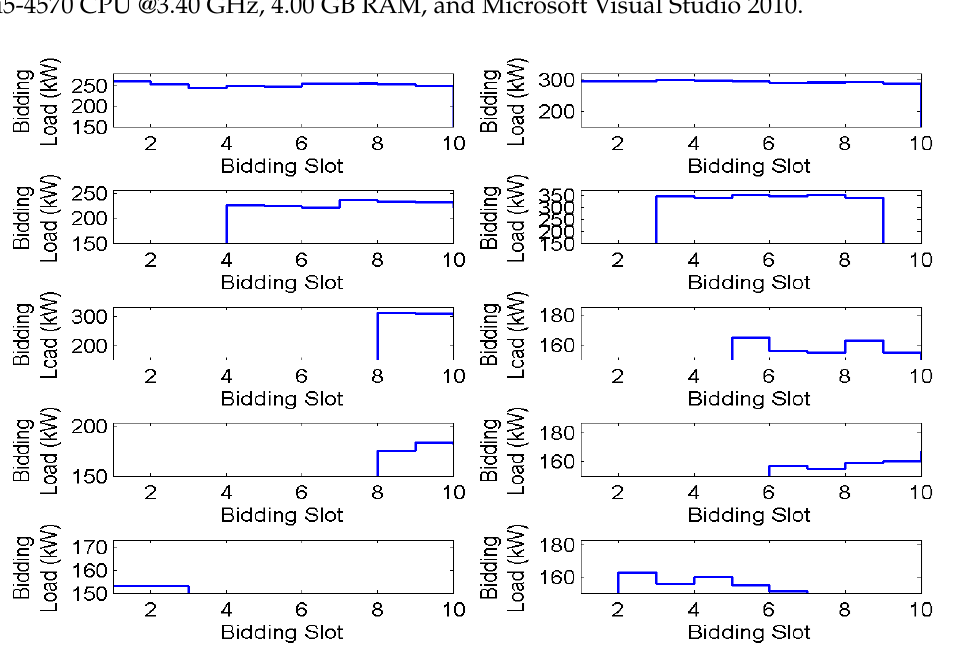
Figure 2. The amount of load curtailment bid by ten randomly selected customers at each bidding slot for case 2 of demand bidding with M =